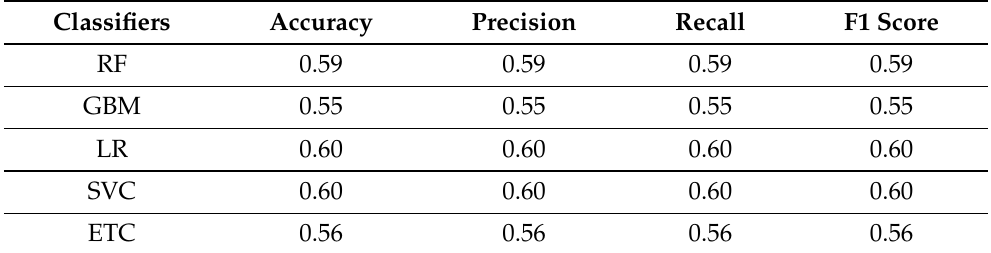
Table 9. Machine learning models results using LR and SVM extracted features.